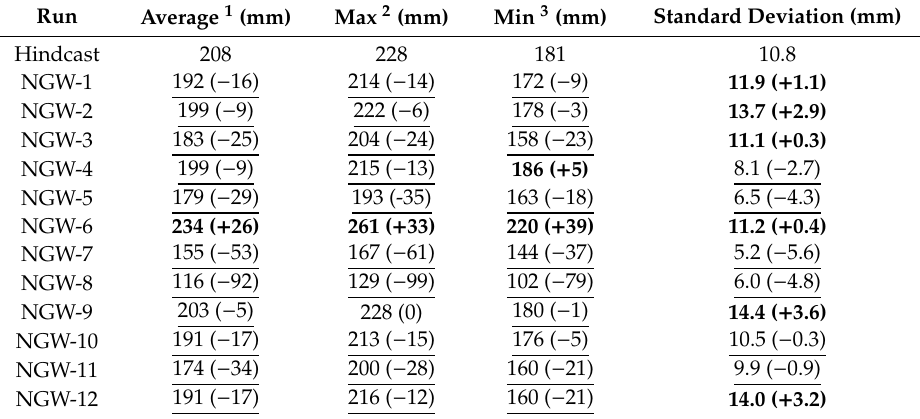
Table 6. Total rainfall averaged for the area A (R T,A ).